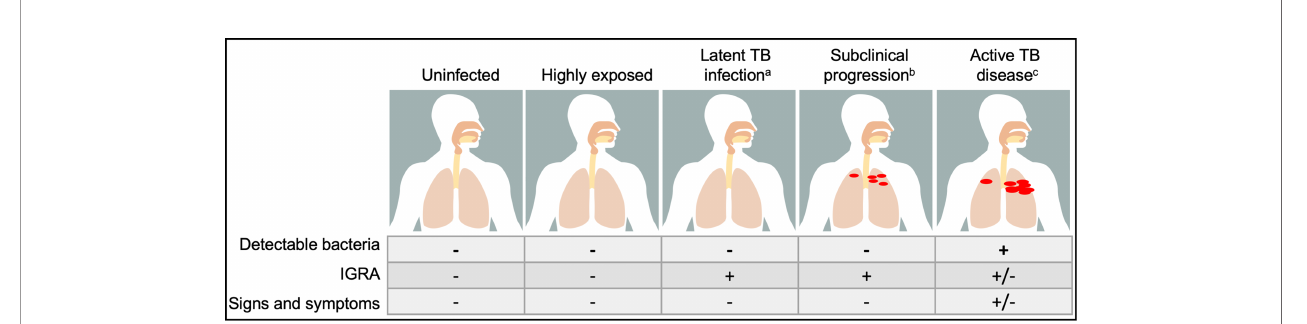
FIGURE 1 | The spectrum of outcomes in human tuberculosis (TB) is heterogenous. Classical clinical states are de fi nes by the presence of detectable bacteria and host response to Mycobacterium tuberculosis antigens by interferon g release assay (IGRA), with uninfected having neither, latent TB infection having a positive IGRA but no detectable bacteria and active TB disease diagnosed by the capture of Mtb by growth in culture, nucleic acid ampli fi cation or cell wall stain. The transition between these states is fl uid and poorly captured by these criteria: a. Individuals who have received antibiotic therapy for latent TB infection cannot be differentiated from those who are treatment naïve. b. Individuals who progress subclinically from latent infection to active disease (5-10%) and those who regress or remain asymptomatic (>90%) are indistinguishable. c. After successful treatment with antibiotics for active TB disease, individuals no longer have detectable bacteria as captured by standard assays but may have residual positive IGRA. Moreover, emerging epidemiological and immune correlates data suggest that beyond these classical states, there are groups who are highly exposed to Mtb who potentially represent an alternative state to latent TB infection not yet clearly de fi